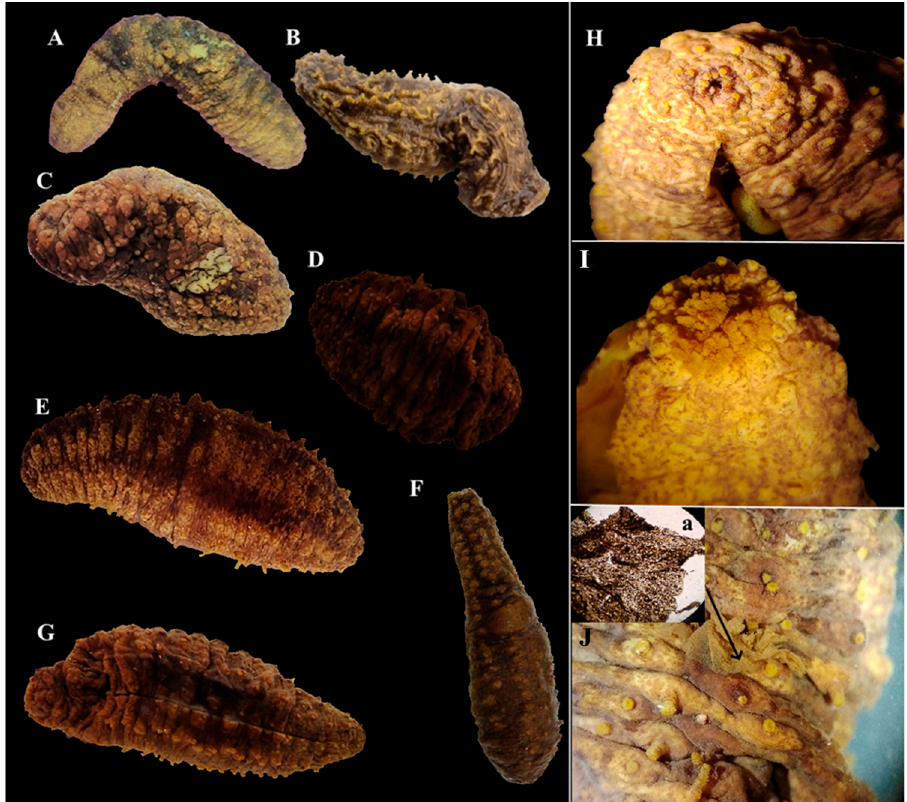
Figure 1. A plate with morphological details of the species Holothuria impatiens in ( A – G ), external morphology of several individuals, ( H ) the anus, ( I ) the oral papillae, and ( J ) details of dorsal podia with ( a ) a layer adhering to the collected individuals.